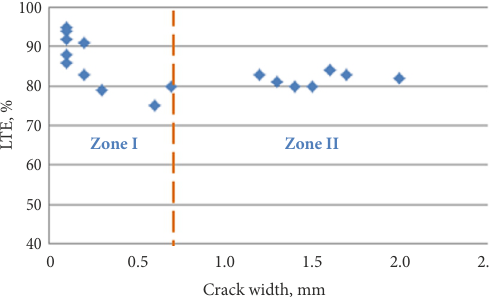
Figure 4. Results of LTE-crack width obtained in the field measurements